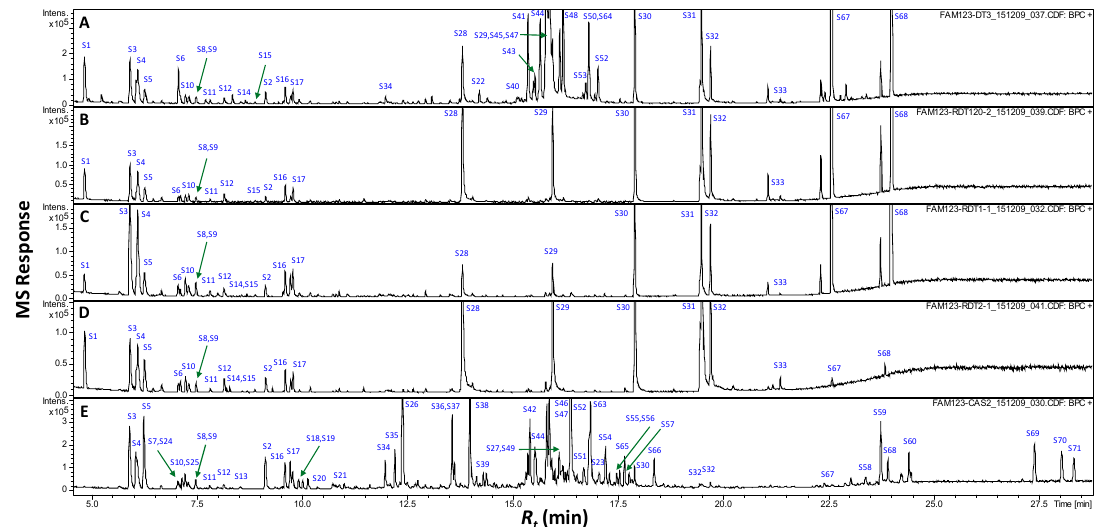
Figure 3. GCMS chromatograms ( R t 5–28 min) of silylated methanol extract from raw pits ( A ), roasted pits ( B ), pit product one ( C ), pit product two ( D ) and co ff ee product ( E ). The corresponding metabolite names for peaks are shown in Table